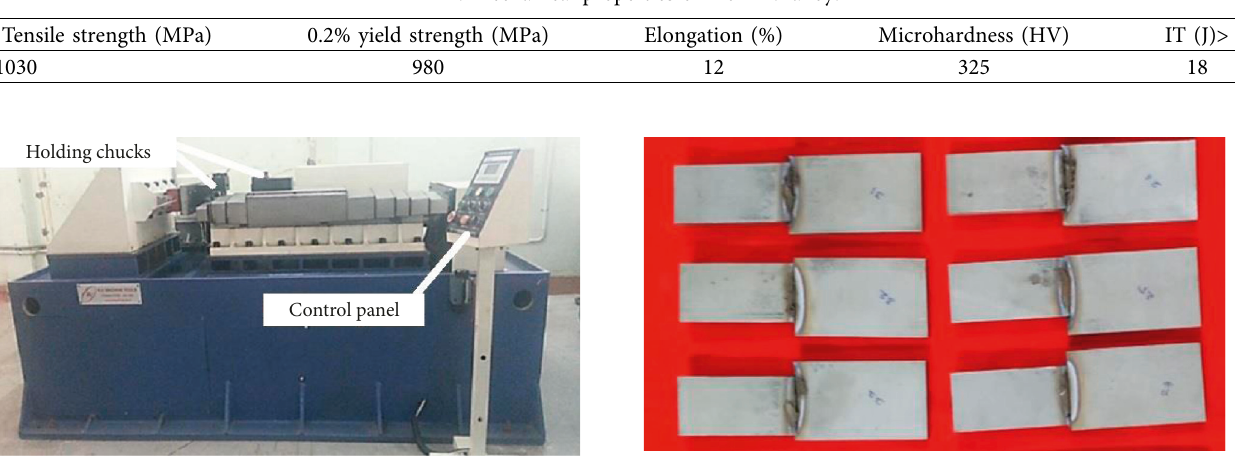
Figure 4: Photograph of fabricated LFW-Ti6Al4V joints. Table 3: Optimized process parameters used to develop the joint.